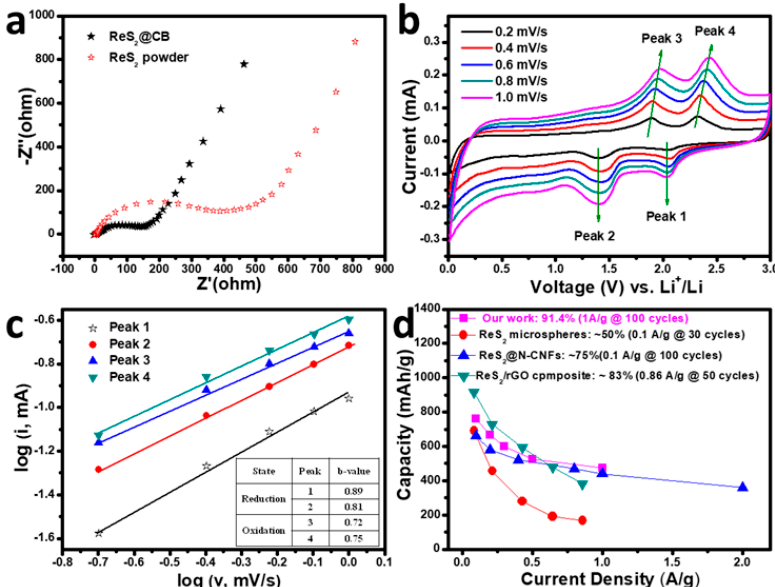
Figure 6. ( a ) EIS data of the ReS 2 @CB and ReS 2 powder samples, ( b ) CV curves of the ReS 2 @CB electrode at the different scan rates, ( c ) correlation between logarithmic peak current (cathodic and anodic peaks) versus logarithmic voltage scan rate, and ( d ) comparison of capacity at the different current densities for the ReS 2 @CB with those of reported ReS 2 -based composite anodes.